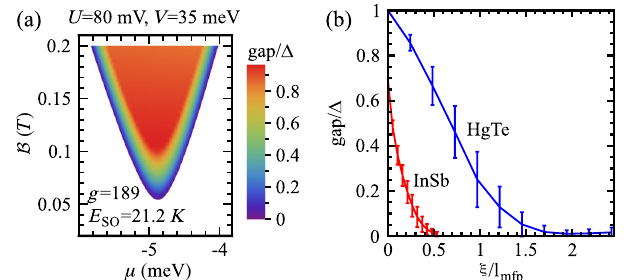
FIG. 7. (a) Phase diagram for a HgTe wire with voltage drop U ¼ 80 mV , confinement depth V ¼ 35 meV , and pairing strength (cid:3) ¼ 0 : 25 meV . The color scale indicates the gap for the topological phase. The combination of a large gap, g factor, and spin-orbit energy render this regime highly favorable ex- perimentally. In particular, the large spin-orbit energy implies reduced sensitivity to disorder. (b) Gap as a function of the ratio of the superconducting coherence length and the mean-free path (cid:11)=l , obtained by solving an effective disordered single-band mfp 1D model for the topological phase realized in (a). The data correspond to a magnetic field B ¼ 0 : 2 T and effective pairing ¼ 0 : 1 meV , with the chemical potential situated amplitude (cid:3) eff in the center of the Zeeman gap. The upper curve corresponds to HgTe parameters relevant for (a), while the lower curve corre- sponds to InSb wire parameters. The larger gap for the former stems from the greatly enhanced spin-orbit